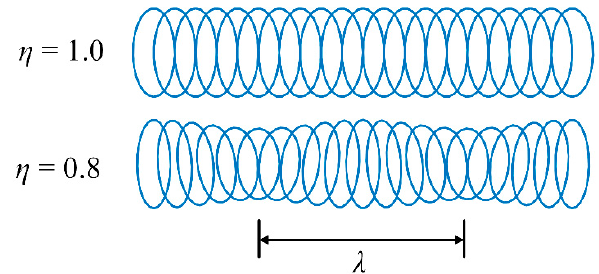
Figure 4. Motion trajectories of one point on the stator’s surface. The amplitudes of the traveling wave are different at different instant points, result- ing in the unstable operating of TRUSM.